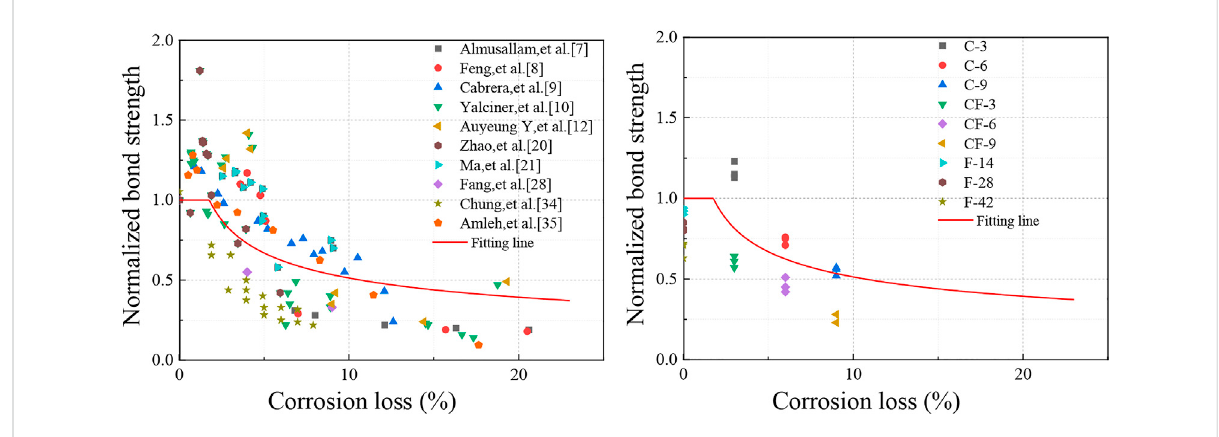
FIGURE 10 Normalized bond strength versus corrosion loss.